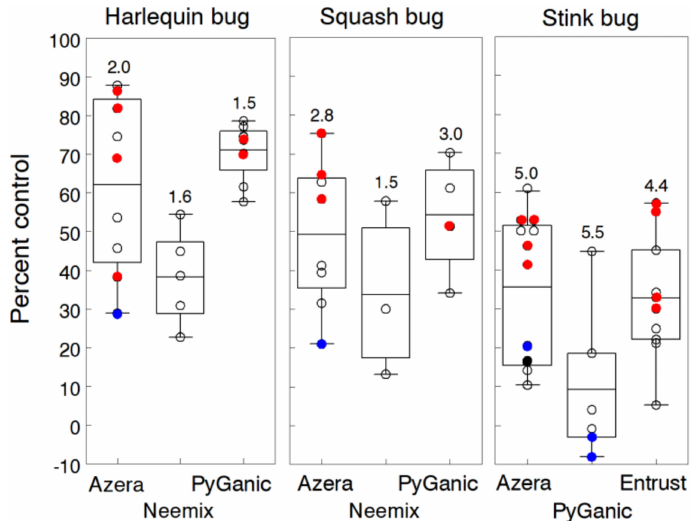
Figure 3. Individual trial results of organic insecticide control of true bugs. Azera, Neemix and PyGanic were evaluated for control of harlequin bug and squash bug, while Azera, PyGanic and Entrust were evaluated against stinkbugs. Mean percent control data for each insecticide are given for six trials with harlequin bug on collards, four trials with squash bug on zucchini and seven trials with stinkbugs on tomato and pepper. Box-whisker plots show the 25% and 75% percentile range of percent control data and the horizontal line in each box is the overall mean control e ffi cacy. Number above each plot indicates the average number of weekly applications. Application rates of Azera, Neemix, PyGanic and Entrust were 2.34 L / h, 1169 mL / h, 2.34 L / h and 71.2 g a.i. / h respectively, except for individual trial data in blue and red indicating lower and higher rates, respectively. Insecticide treatments for each true bug were not significantly di ff erent, except for PyGanic, which provided significantly better control of harlequin bugs than the other